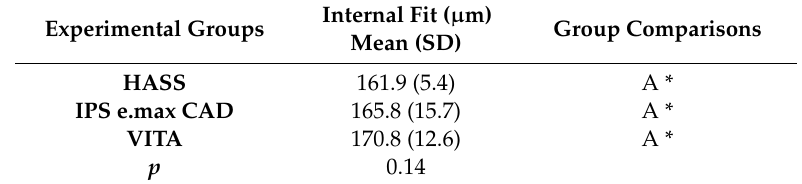
Table 5. Comparison of the internal fit according to the type of lithium disilicate